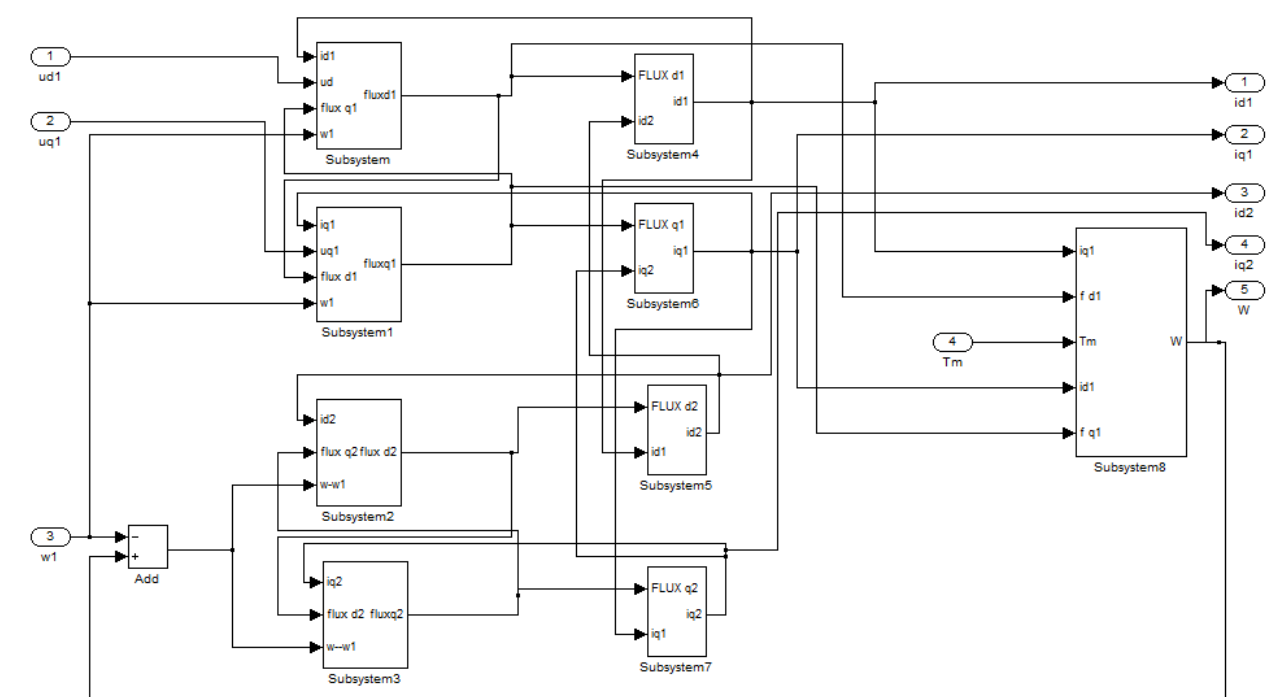
Figure 2. Simulink model of a 3-phase induction motor under normal conditions.